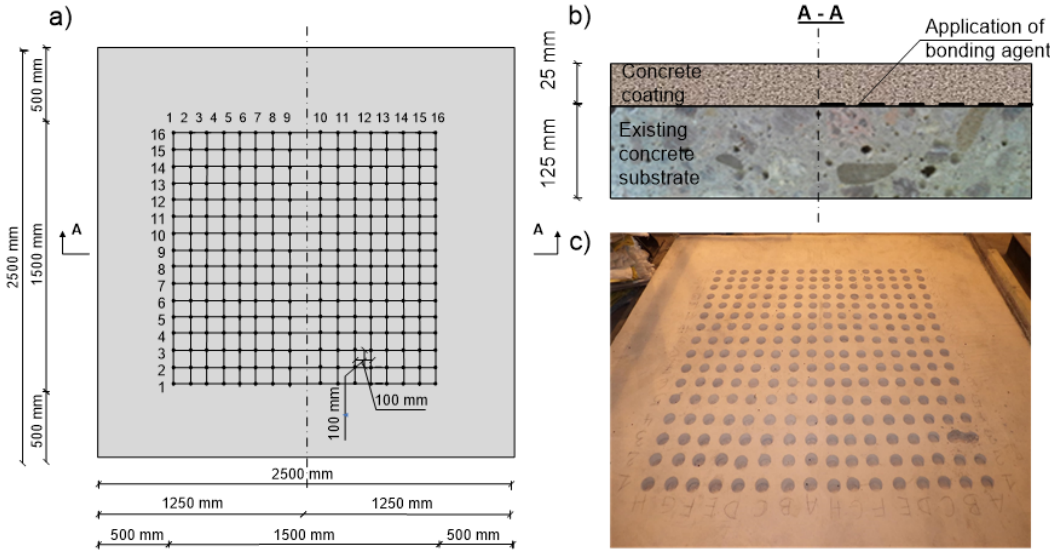
Figure 1. The tested two ‐ layer cement composite: ( a ) arrangement of testing areas on the surface of the overlay; ( b ) cross ‐ section; and ( c ) view of the surface of the overlay after pull ‐ off testing. Table 1. Weight composition of mixes.